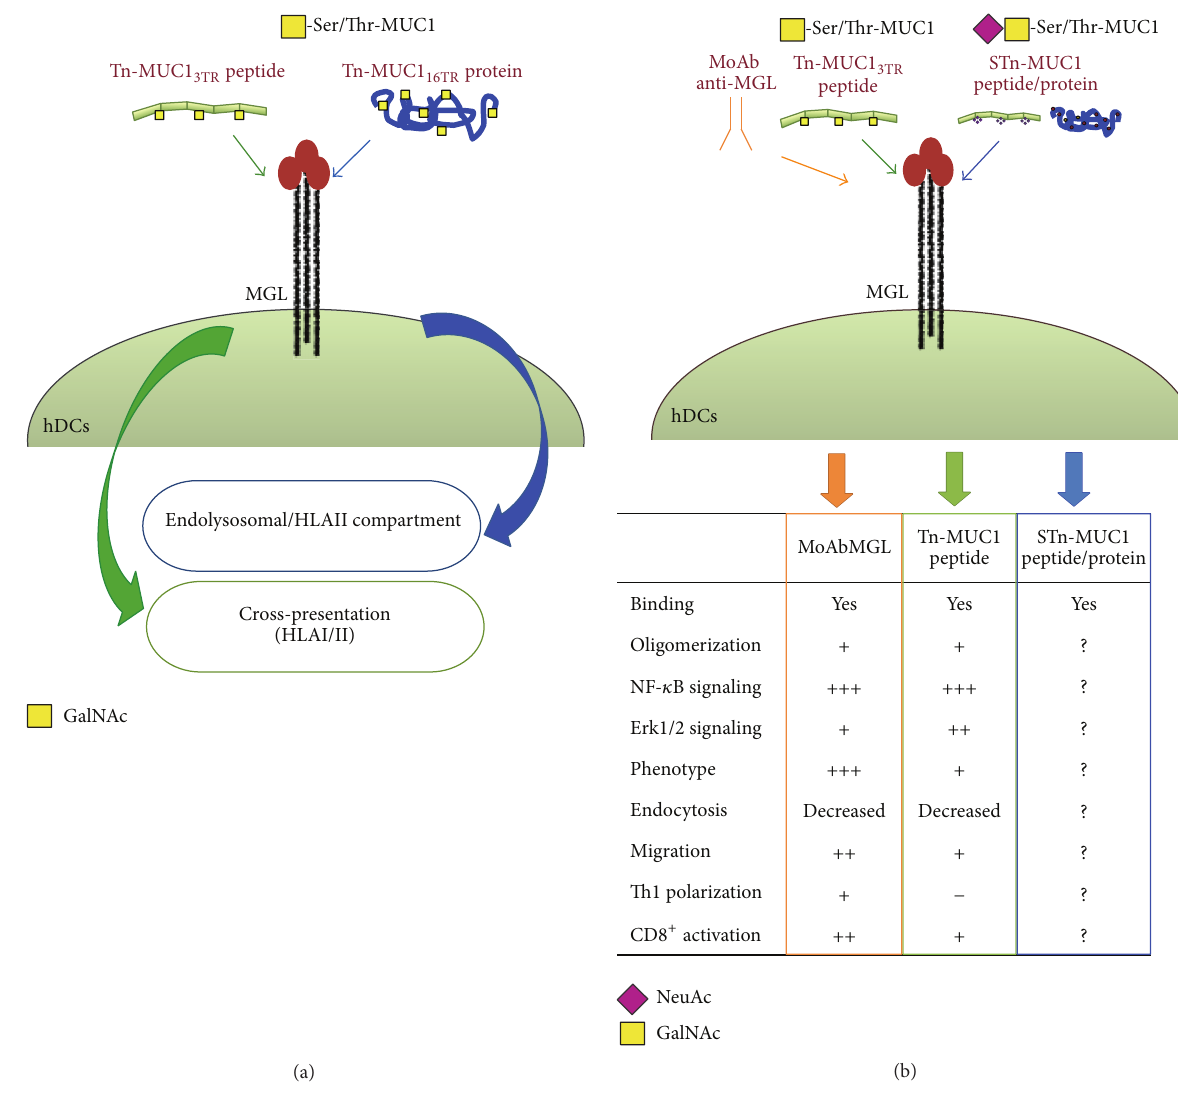
Figure 3: The structure of tumor antigen formulations internalized by MGL influences their processing and DC performance. (a) Recombinant Tn-MUC 1 16 TR protein remains blocked in DCs HLA class II compartment after internalization through MGL, while the shorter Tn-MUC 1 3 TR peptide (60 amino acids) is processed in HLA classes I and II compartments. (b) Effects induced on DC functions by MGL engagement with MoAb anti-MGL and Tn-MUC1